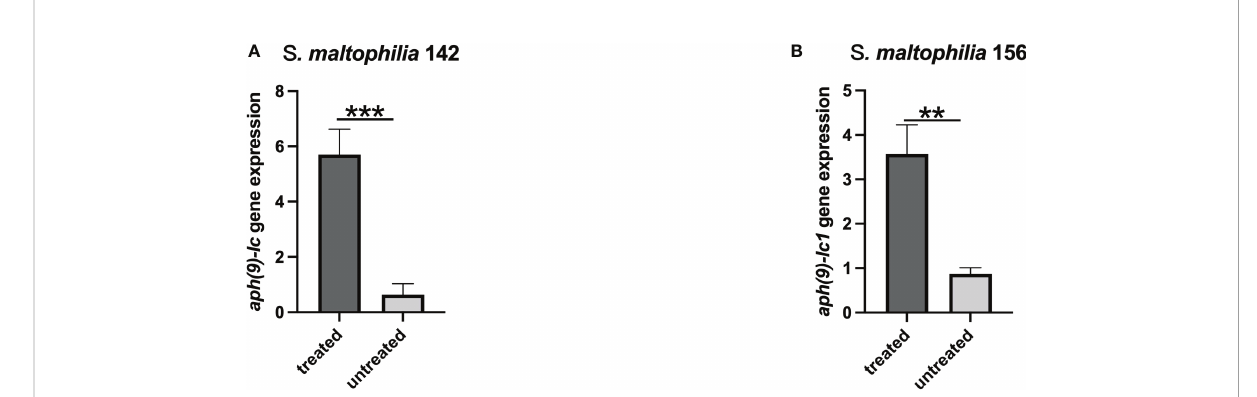
FIGURE 1 Expression levels of the aph(9)-Ic genes in S. maltophilia 142 and S. maltophilia 156 treated or untreated with spectinomycin. (A) S. maltophilia 142 treated with 4,096 m g/mL spectinomycin; (B) S. maltophilia 156 treated with 2,048 m g/mL spectinomycin. Bars represent the mean ± standard error, and all experiments were performed in triplicate. ** represents P < 0.01; *** represents P <